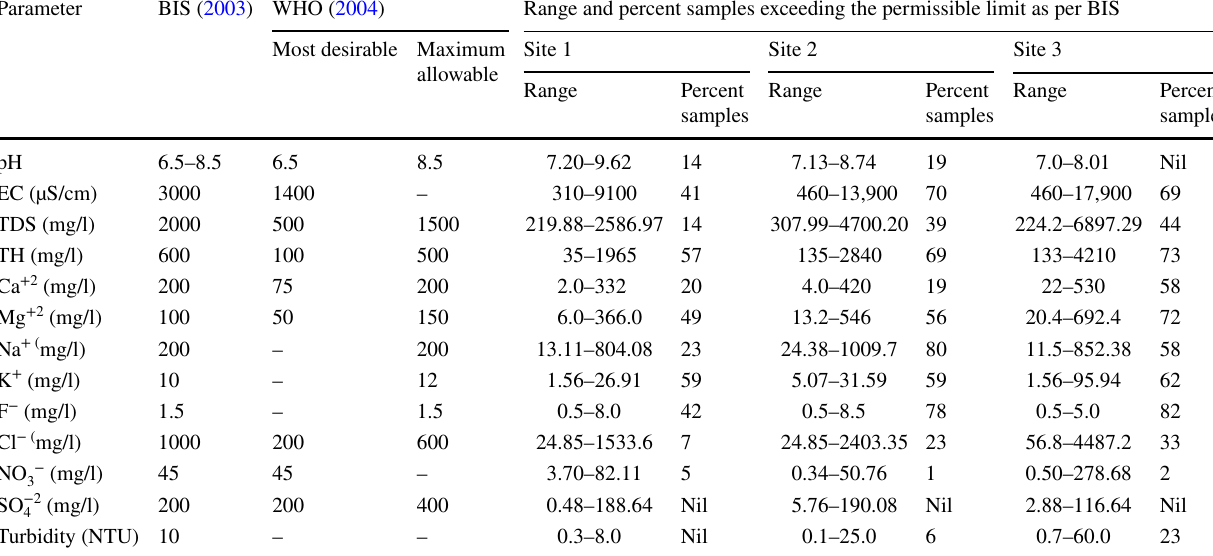
Table 4 Groundwater samples of the study area exceeding the recommended permissible limits for drinking purposes Parameter